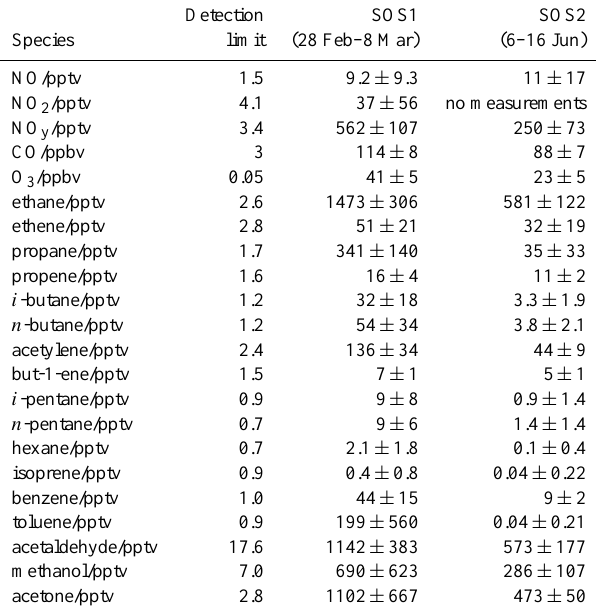
Table 2. Summary of the mean and standard deviations of NO, NO 2 , NO y , CO, O 3 and VOCs at the CVAO during the HO x - measurement periods of SOS1 and 2. Note that the NO, NO 2 and NO y data coverage was sporadic across these